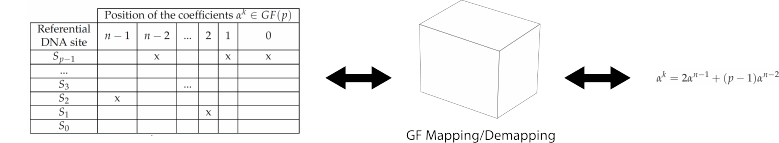
Figure 7. Galois Field Mapping/Galois Fields Demapping